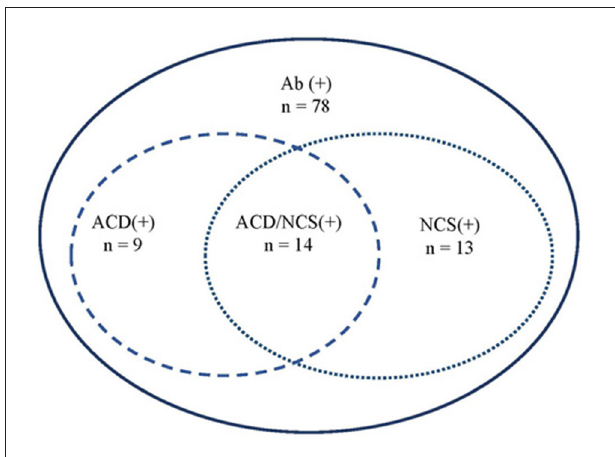
FIGURE 3 | Correlation between ACD and NCS. Ab, anti-GQ1b antibodies; ACD, albuminocytologic dissociation; NCS, nerve conduction study.